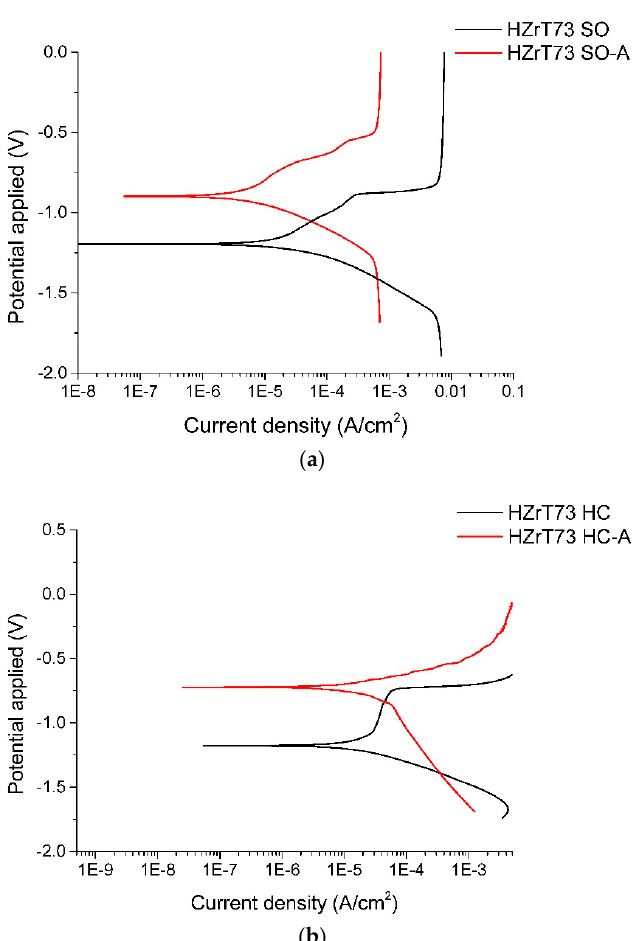
Figure 8. Polarization curves with or without anodization of ( a ) HZrT73 SO and ( b ) HZrT73 HC samples immersed in a 1 M NaCl solution. Table 4. Potentiodynamic polarization measured for HC and SO samples (HC-A and SO-A: anodized samples); standard deviations are included in the parentheses.